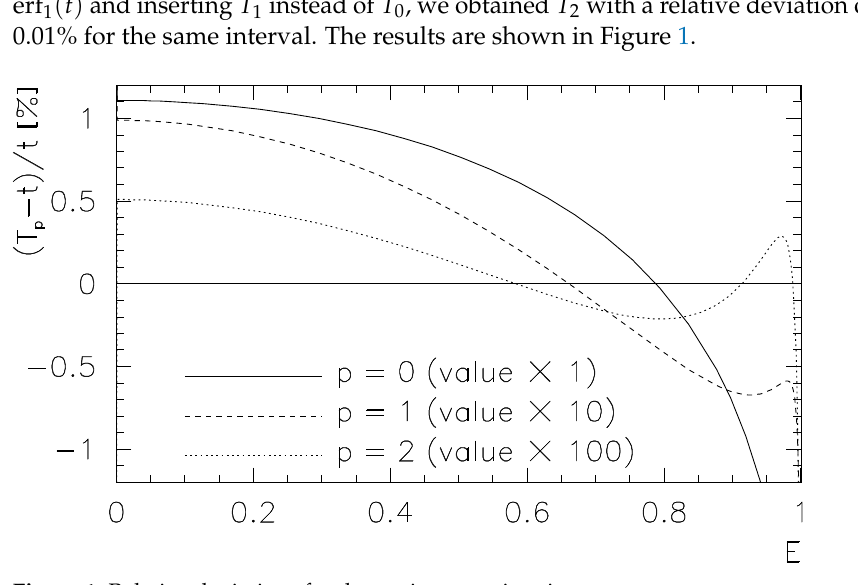
Figure 1. Relative deviations for the static